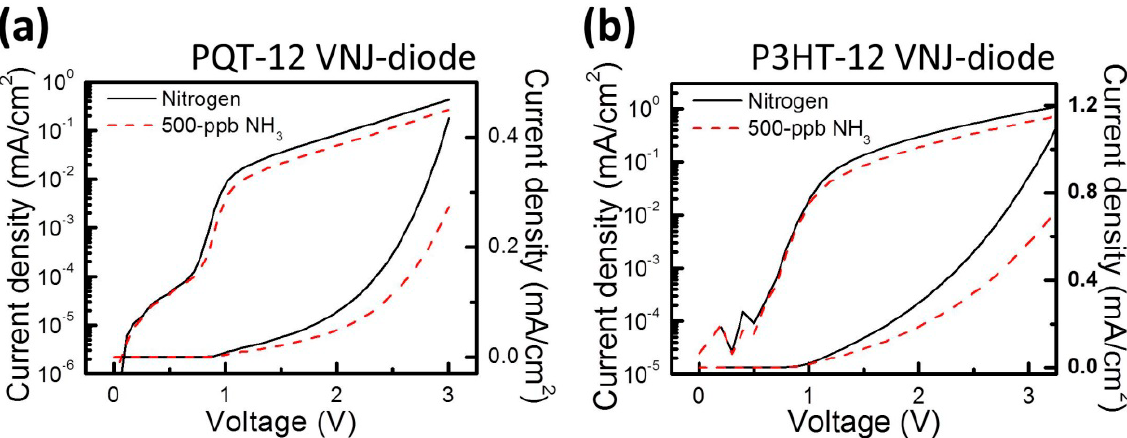
Figure 3. The current densities as a function of the applied bias (J–V) of the ( a ) PQT-12 VNJ-diode and ( b ) the P3HT VNJ-diode before ammonia sensing (solid line) and after 200-s, 500-ppb ammonia sensing (dashed